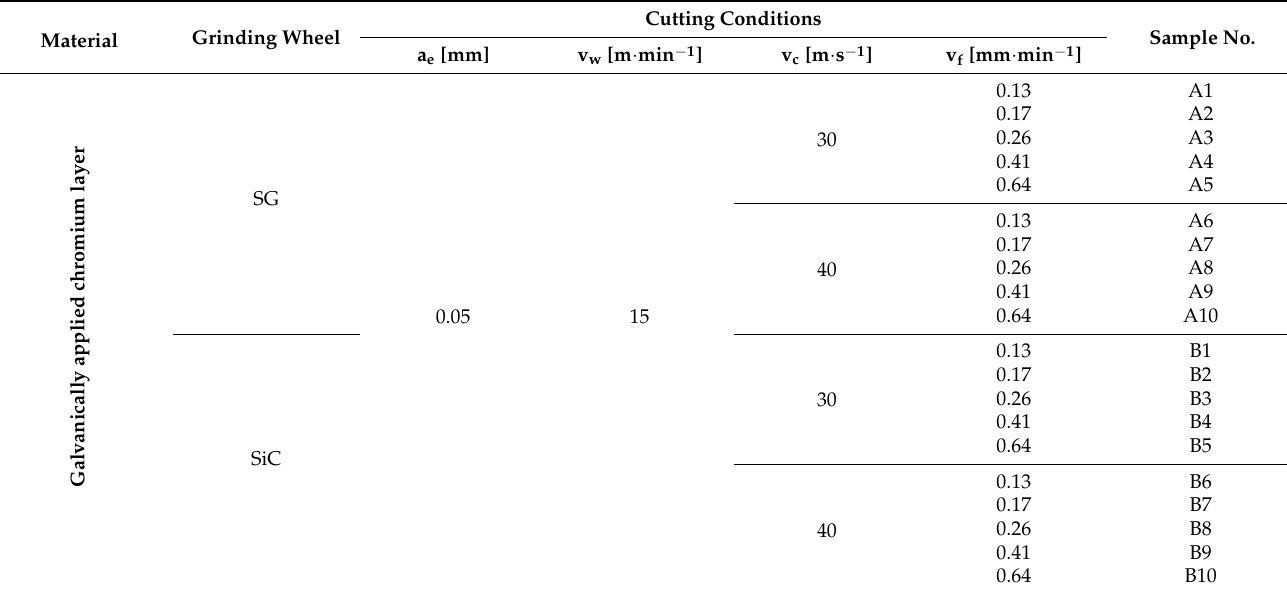
Table 4. Cutting conditions of the